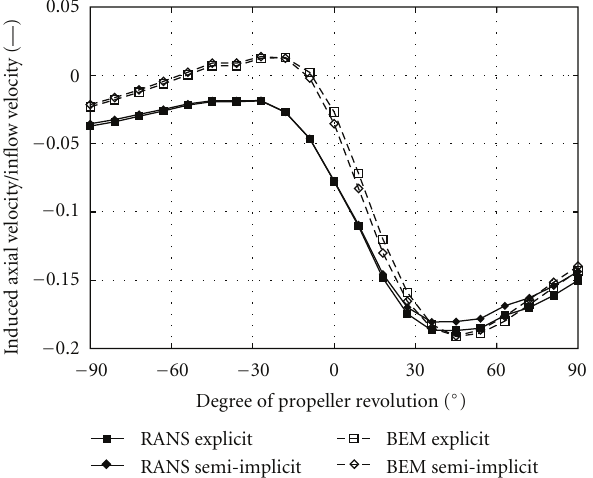
Figure 7: Comparison of the normalised induced axial velocities obtained from the explicit and the semi-implicit coupling approach ( r/R = 0 . 7, J = 0 . 5, dt · n = 3 . 78 ◦ , and dx = 0 . 5 R